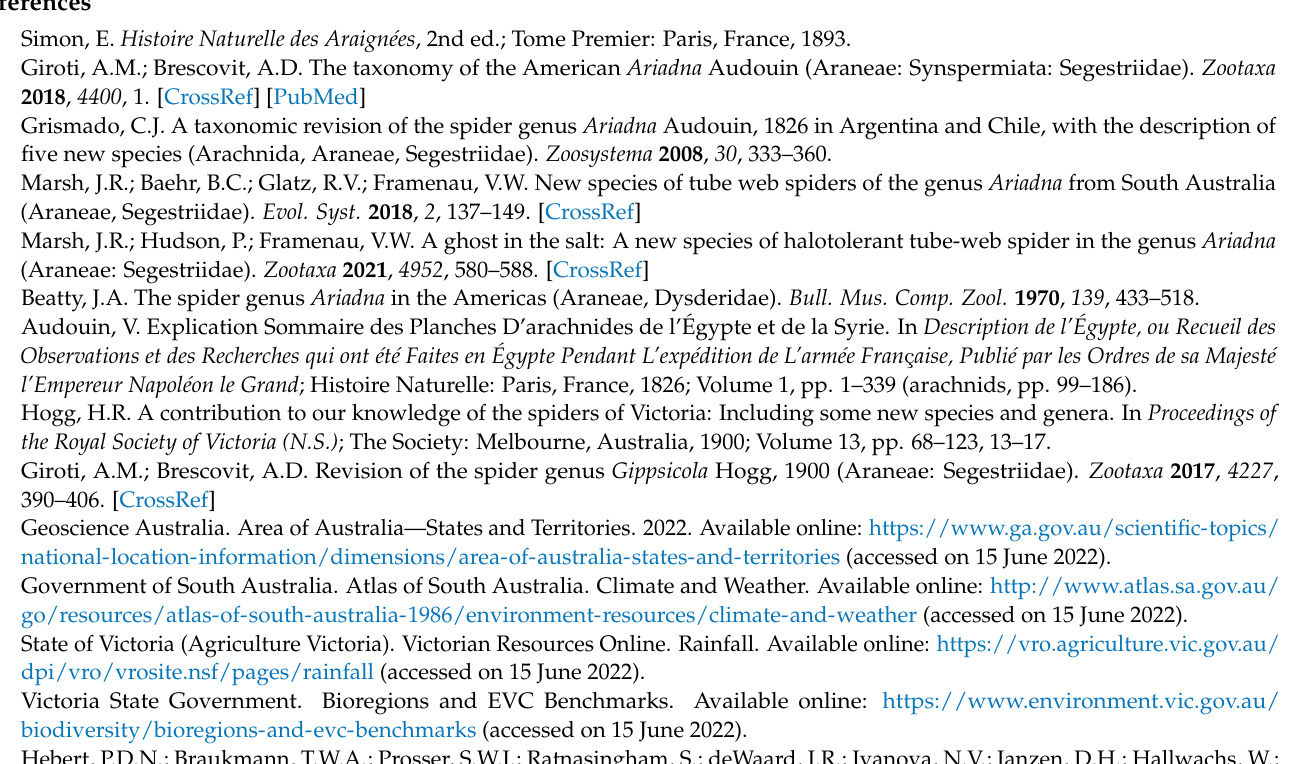
Figure 2. Details for each are in Table 1. Table S3: Position of apophyses on metatarsus I of males; analysis of variation in the pattern and number of macrosetae for males and females of species where more than one specimen is